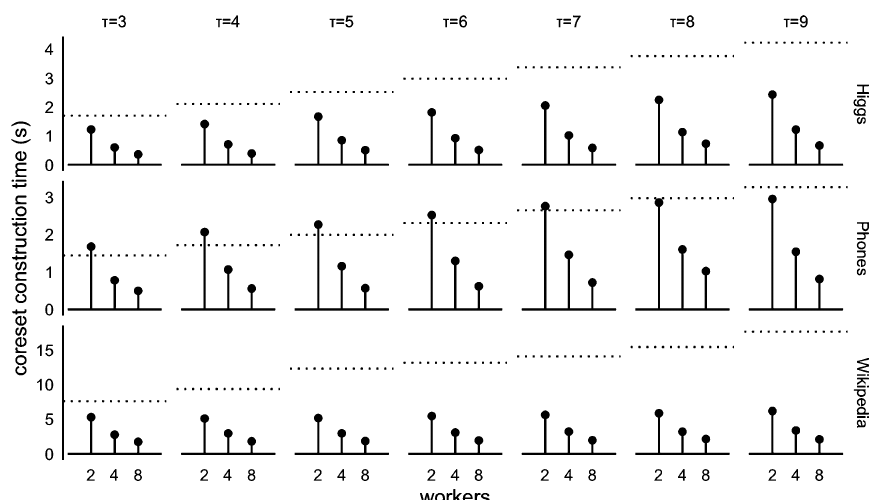
Fig. 4 Time to build the coreset with the mrC oreSet algorithm, for varying number of workers. Each column of plots corresponds to a different value of τ . The dotted line represents the performance of the S eq C oreSet algorithm in constructing the coreset. The time scale is